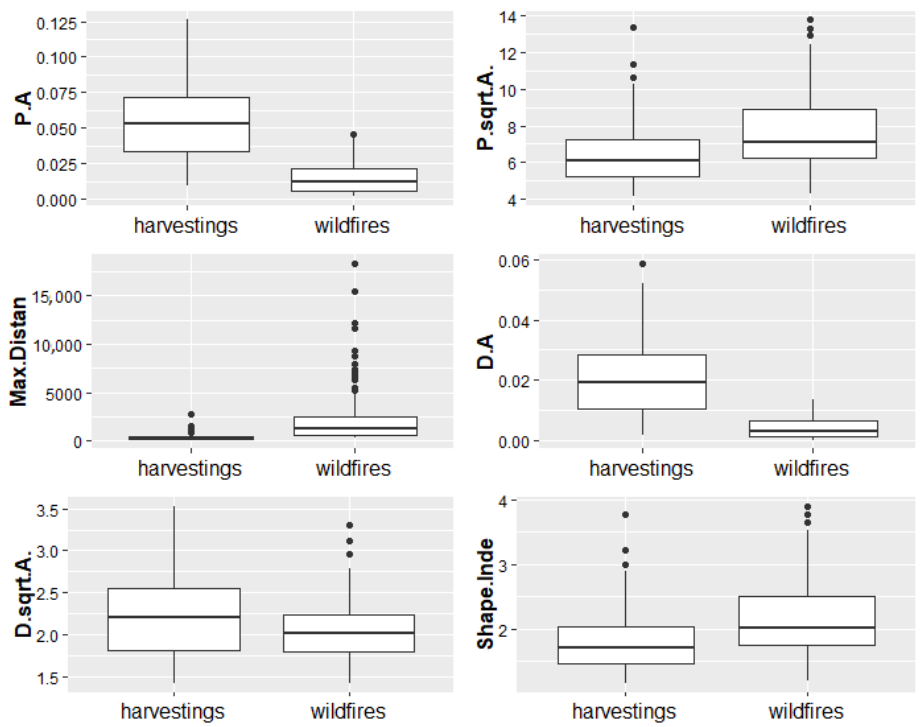
Figure 8. Paired boxplots of the metrics calculated focused on the shape of the polygon formed by the cluster. Boxplots are median based.